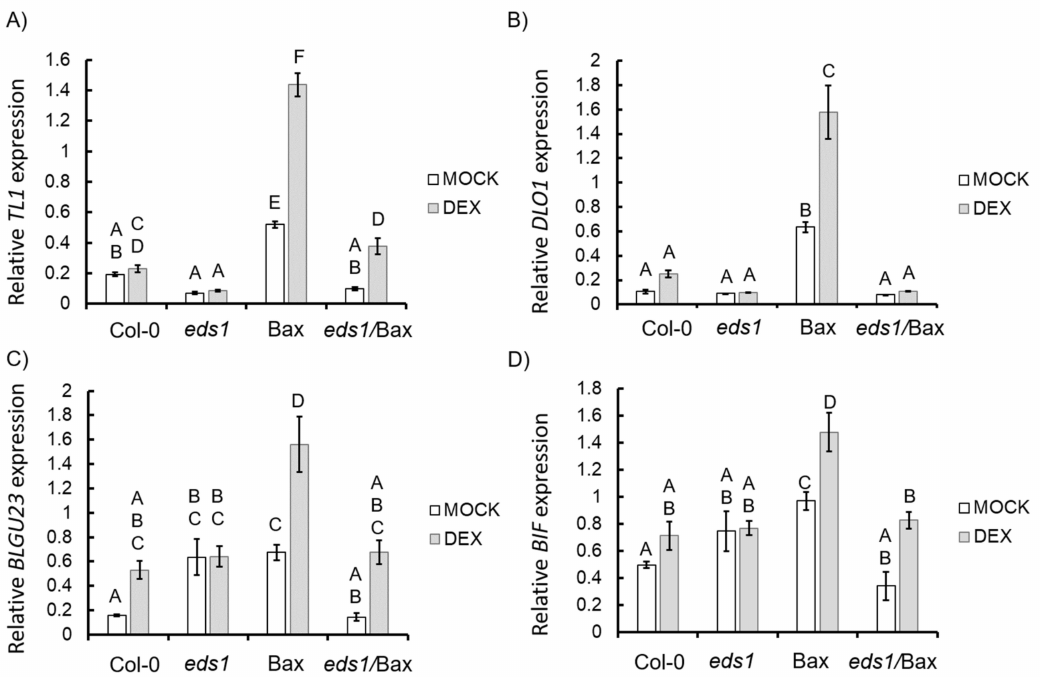
Figure 4. Relative expression level of marker genes of di ff erent reactive oxygen species (ROS) forms in the wild type, eds1 mutant, and Bax and eds1 / Bax lines ( + mock /+ DEX): marker gene for ( A ) many ROS forms ( TL1 ), ( B ) hydrogen peroxide (H 2 O 2 ) ( DLO1 ), and superoxide (O 2 − ) ( C ) BLGU23 and ( D ) BIF ). Within a subgraph, conditions sharing common labels (letters) are not significantly di ff erent from each other ( p > 0.001) ( n =